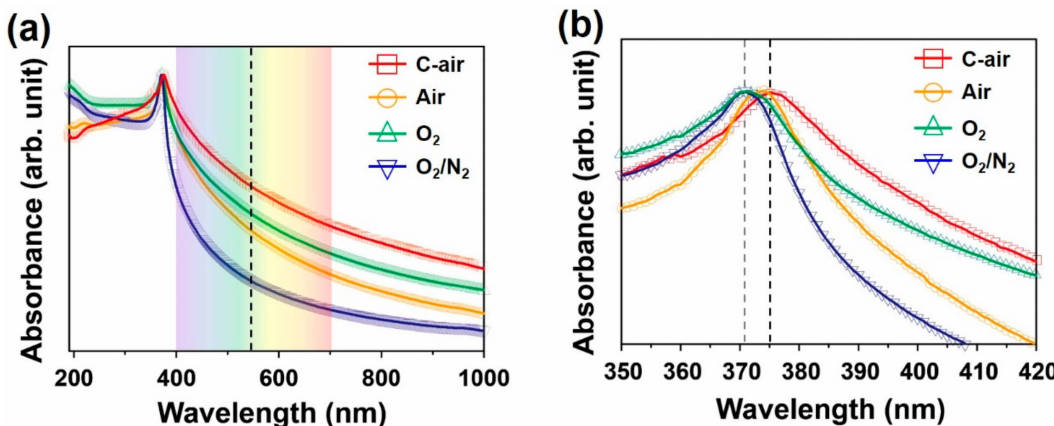
Figure 5. ( a ) Wide-range and ( b ) narrow-range UV-visible absorption spectra of ZnO nanomaterials synthesized using di ff erent